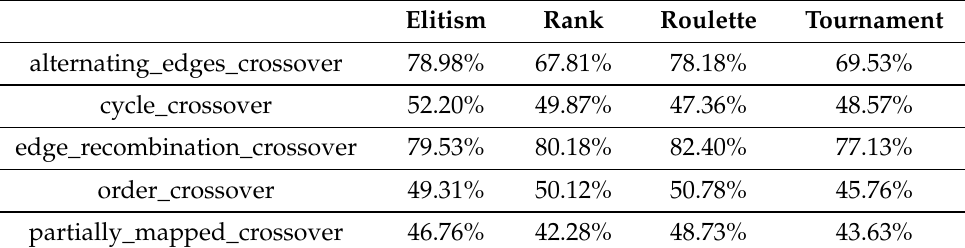
Table 2. All combinations, moderate settings, fast experiment–averaged results from all instances from first experiment.